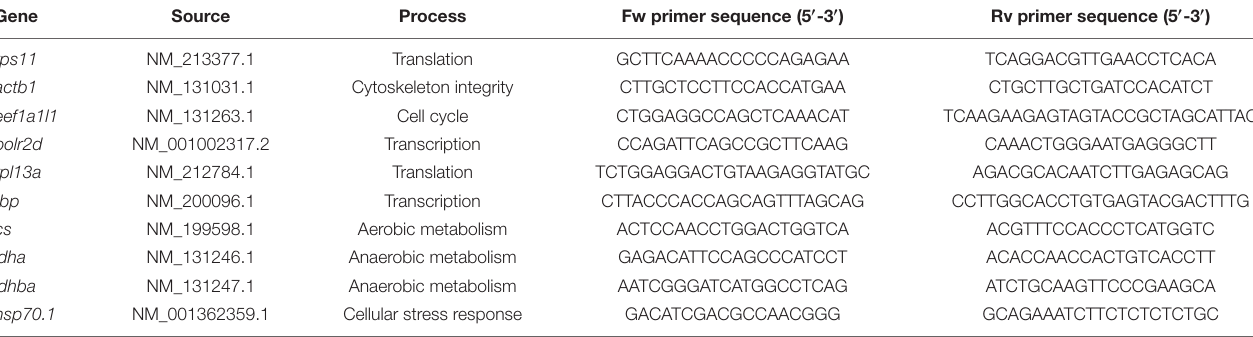
TABLE 1 | Primer sequences for qPCR.